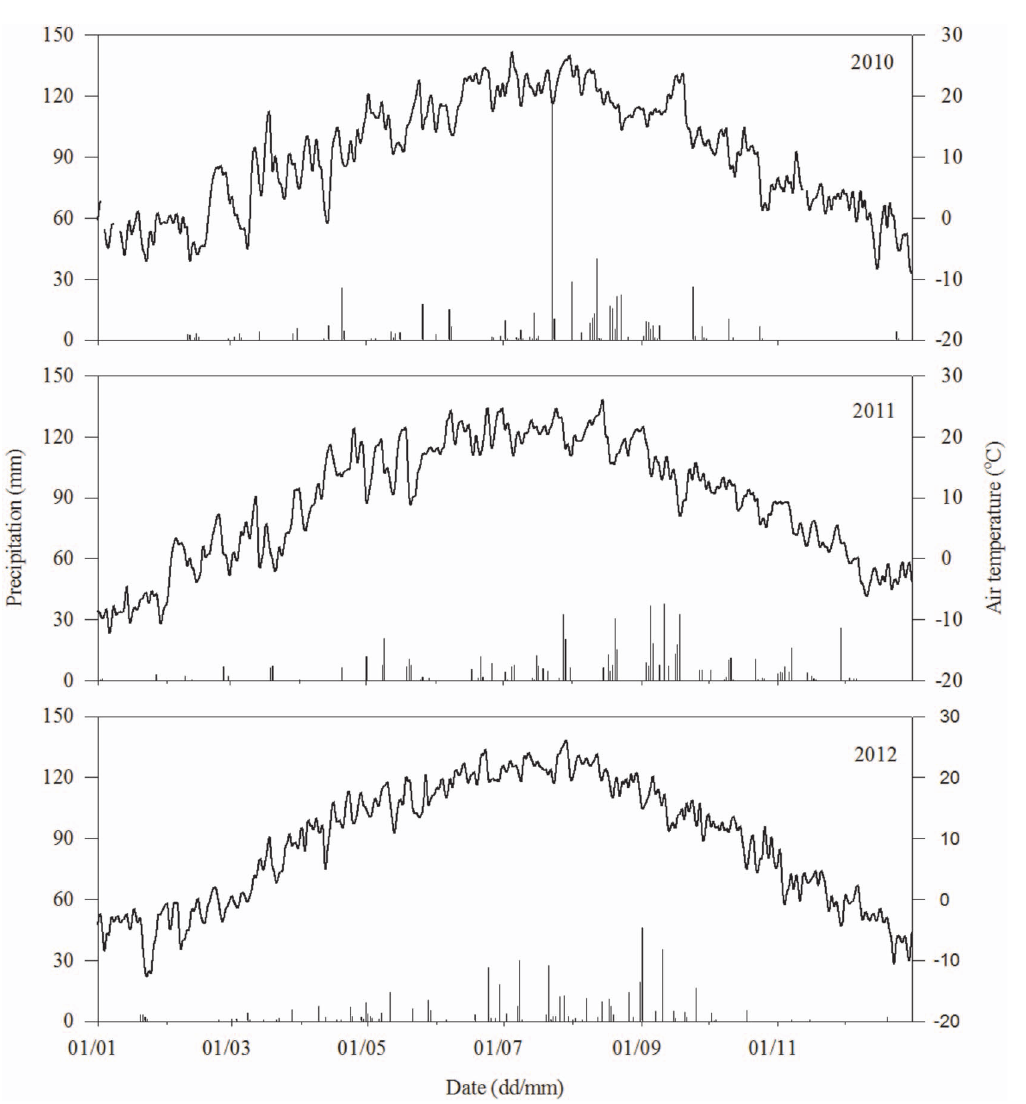
Figure 1. Variation in rainfall (mm) and air temperature ( ˚ C) in 2010, 2011, and 2012,